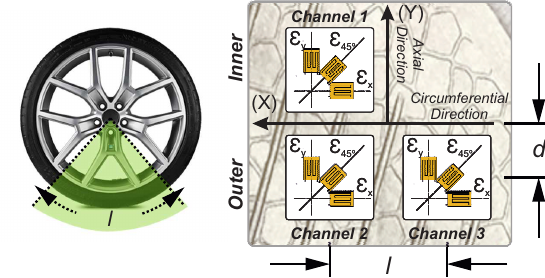
Figure 2. Disposition of the multiaxial gauge strain